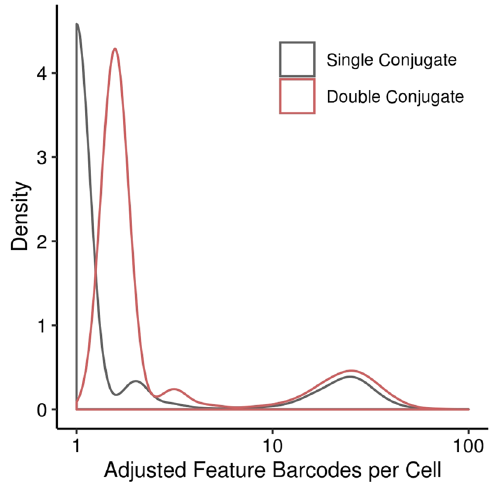
Single and double conjugated-oligonucleotide antibodies in quantitative sequencing read count statistics.